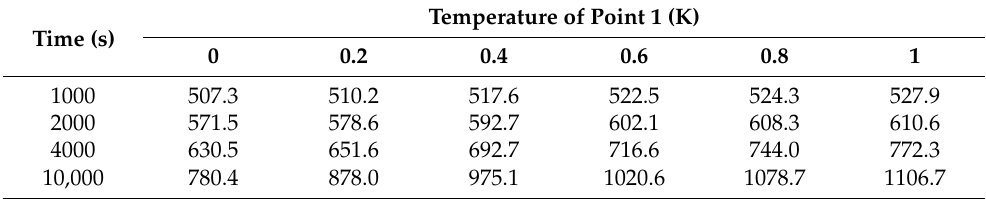
Table 10. Temperature with different intra-pore emissivity at different times.